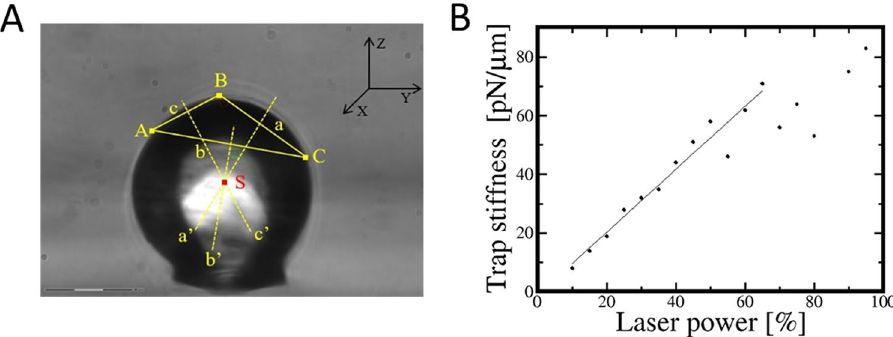
Figure 3. ( A ) The determination of sphere center based on 2D image (analytical approach); ( B ) The dependence of a trap stiffness on the laser